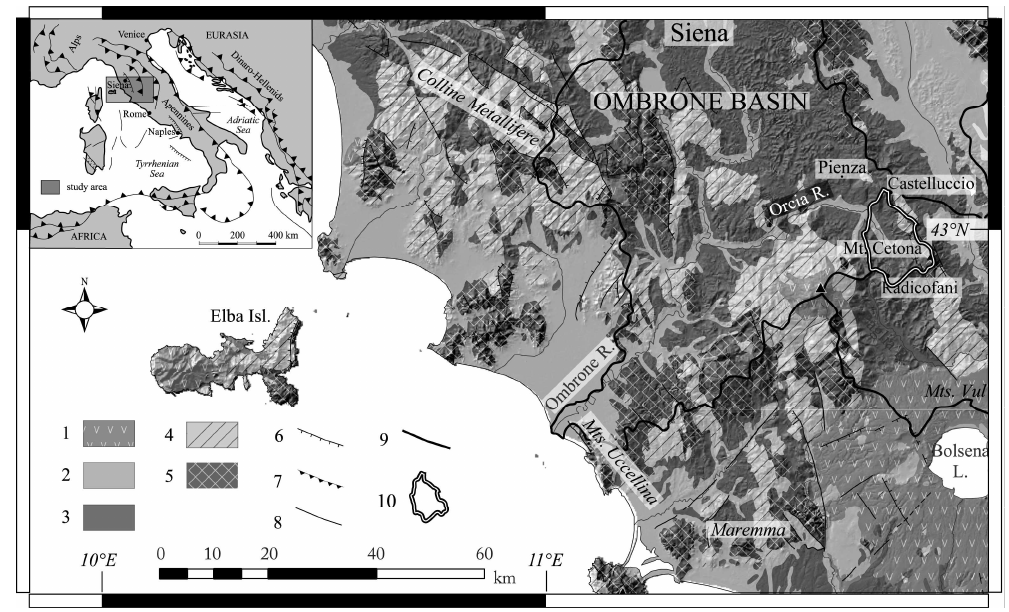
Figure 3: Location of the study area and geological sketch of the Tyrrhenian side of central Italy: 1) Quaternary volcanic rocks; 2) Quaternary undifferentiated continental deposits; 3) Plio-Pleistocene terrigenous marine deposits and Messinian evaporites; 4) sedimentary and metamorphic units of Ligurian and sub-Ligurian nappes (Trias to Lower Cretaceous); 5) sedimentary and metamorphic units of Tuscan nappe (Paleozoic to Miocene); 6) Normal fault; 7) Overthrust and reverse fault; 8) Undetermined fault; 9) Watershed; 10) Study area.